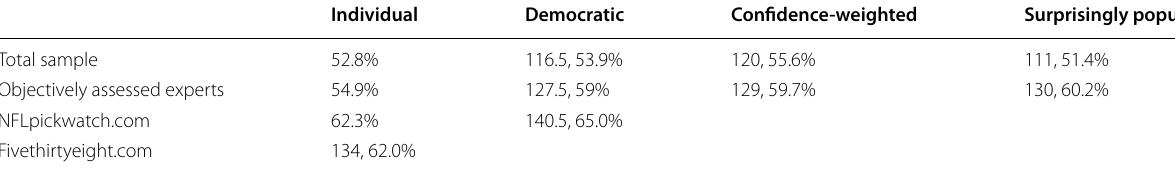
Table 1 Performance (correct predictions, % correct) across aggregation methods